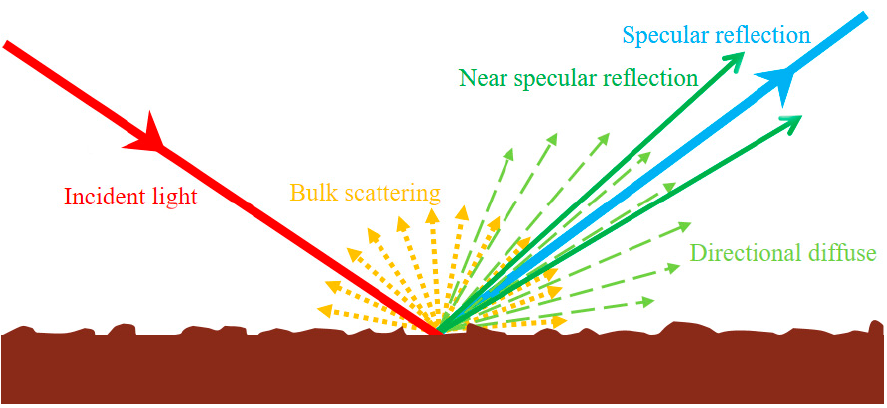
Figure 1. A systematic illustration of light scattering at a randomly micro rough surface.